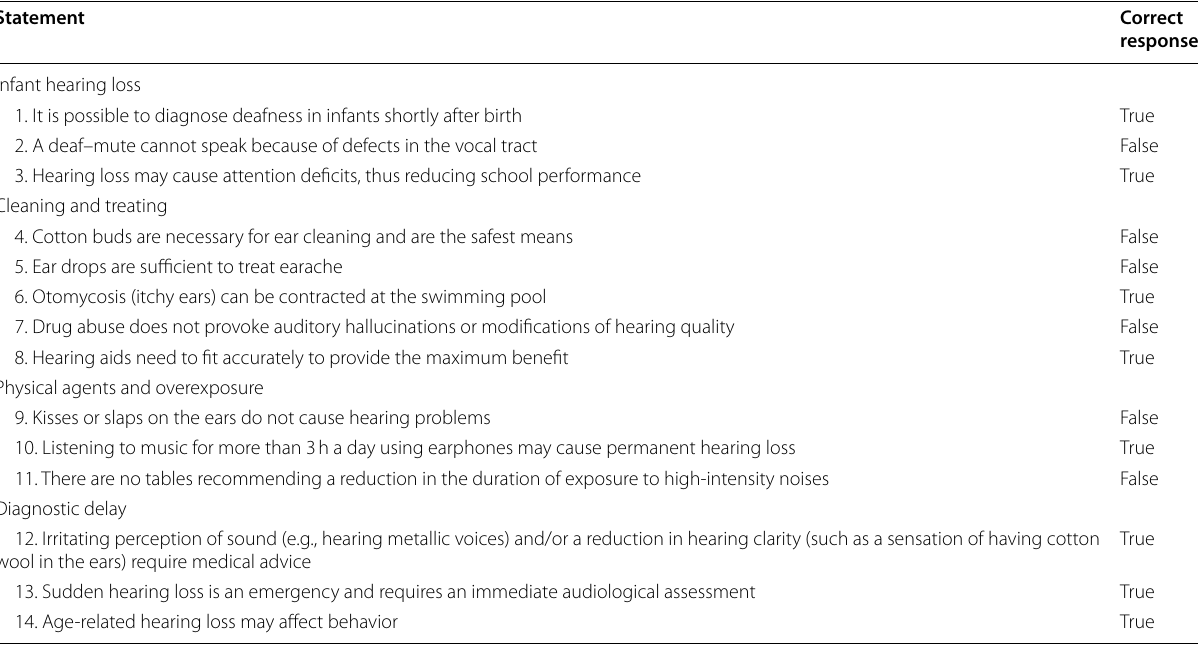
Table 1 Questionnaire to evaluate parents’ awareness of ear health and hearing